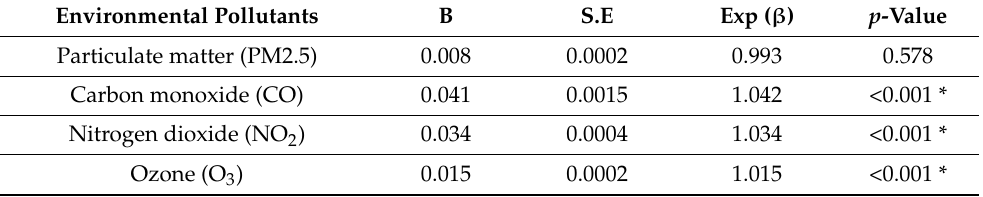
Table 4. Poisson Regression—PM2.5, CO, NO 2 and O 3 with the number of deaths due to SARS-CoV-2. Environmental Pollutants B